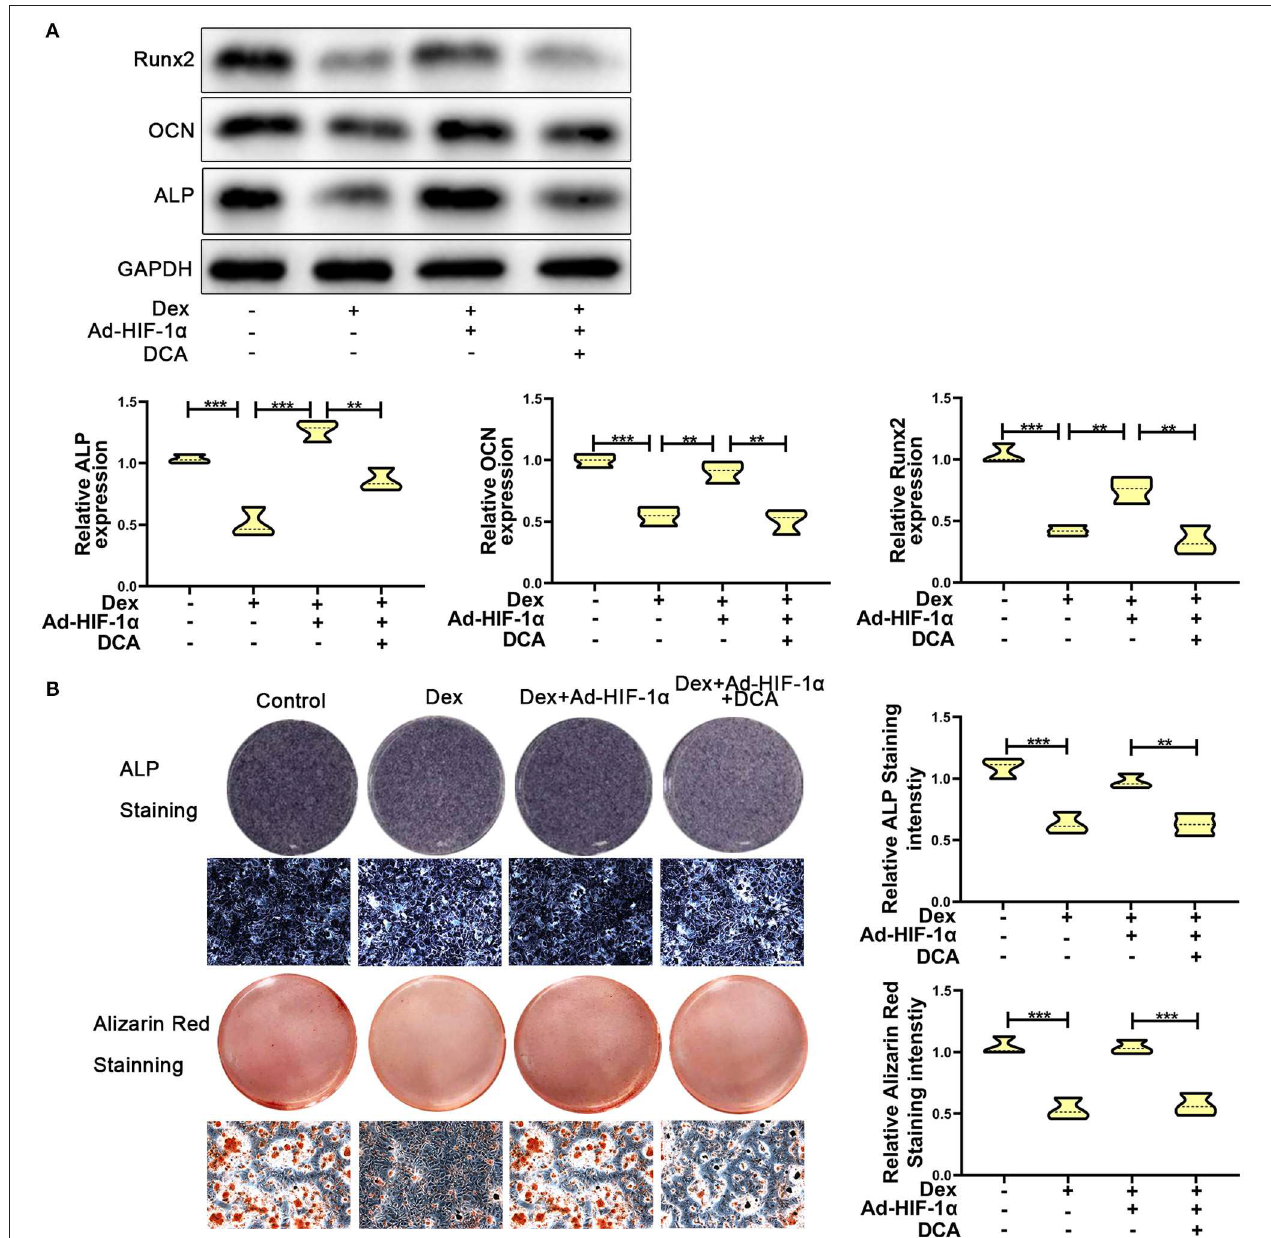
FIGURE 3 | Repression of PDK1 reversed the protective effect of Adenovirus-HIF-1 α on glucocorticoid-induced osteogenic inhibition in MC3T3-E1 cells. (A) The protein expression levels of osteogenic markers Runx2, OCN, ALP, and GAPDH were determined by western Blotting in MC3T3-E1 cells exposed to empty vector, dexamethasone, dexamethasone + Ad-HIF-1 α , and dexamethasone + Ad-HIF-1 α + DCA, respectively. (B) ALP and Alizarin red Staining were performed to determine the osteogenic ability of MC3T3-E1 cells exposed to empty vector, dexamethasone, dexamethasone + Ad-HIF-1 α , dexamethasone + Ad-HIF-1 α +